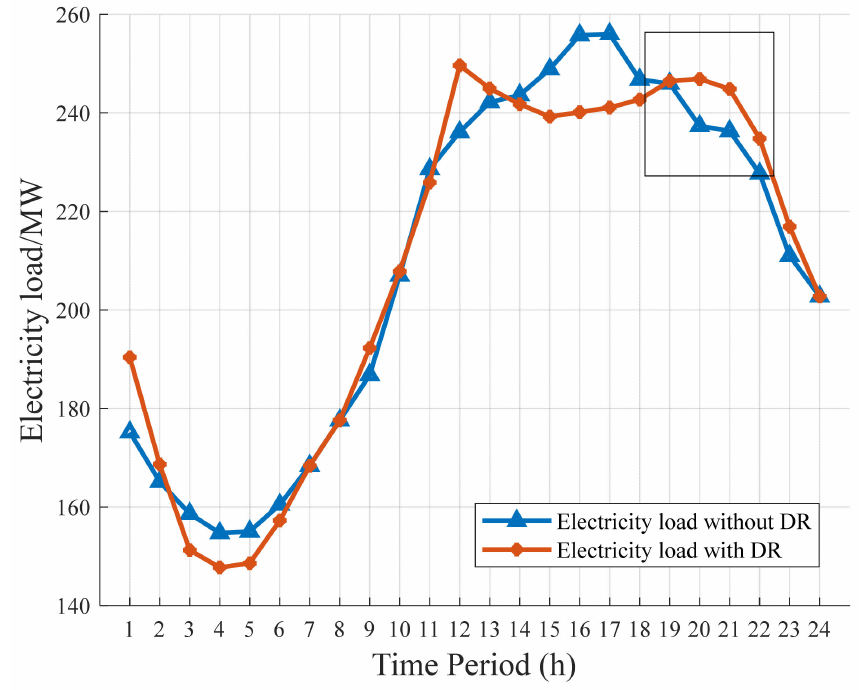
Figure 10. Electricity load profile without and with demand